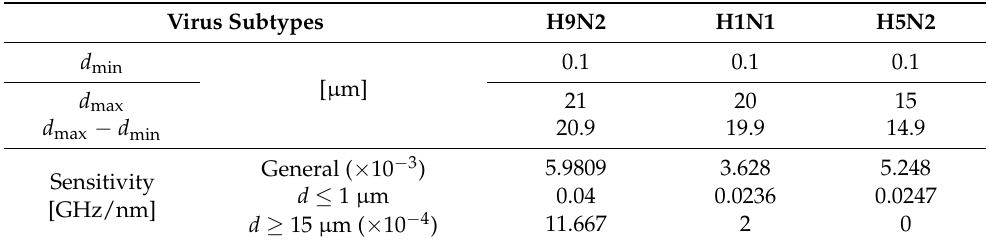
Table 6. Numerical representation of sensitivity parameters around the second peak for CrossPMA. Minimal absorption is declared at 50% of the absorption value of the unloaded sensor.